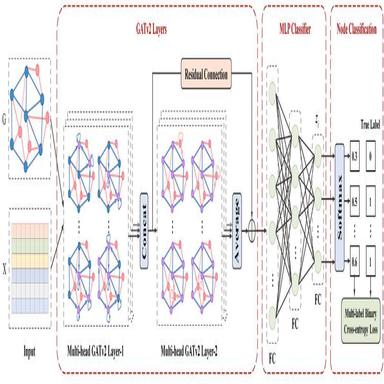
The proposed DGAT-NS model.